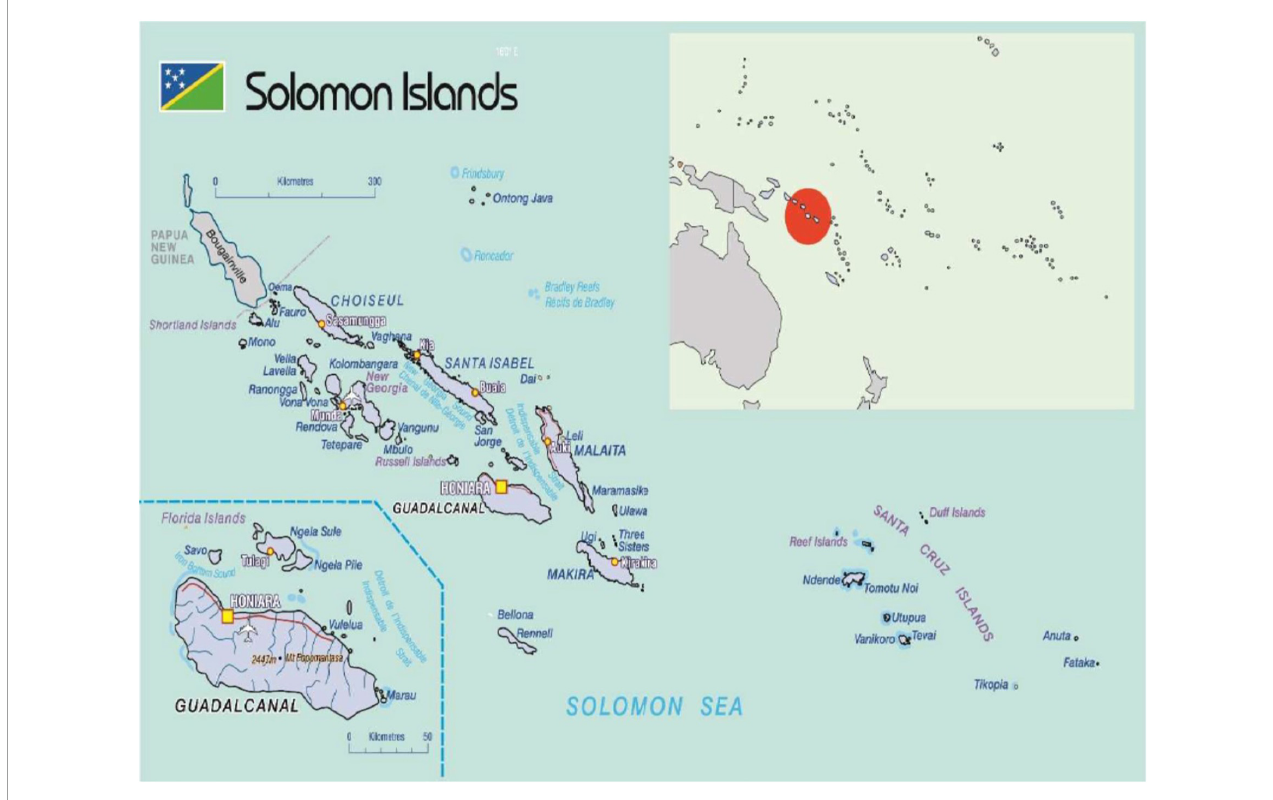
FIGURE1 Map of Solomon Islands within the Pacific region, highlighting Guadalcanal Province in blue and Honiara in yellow (bottom left)